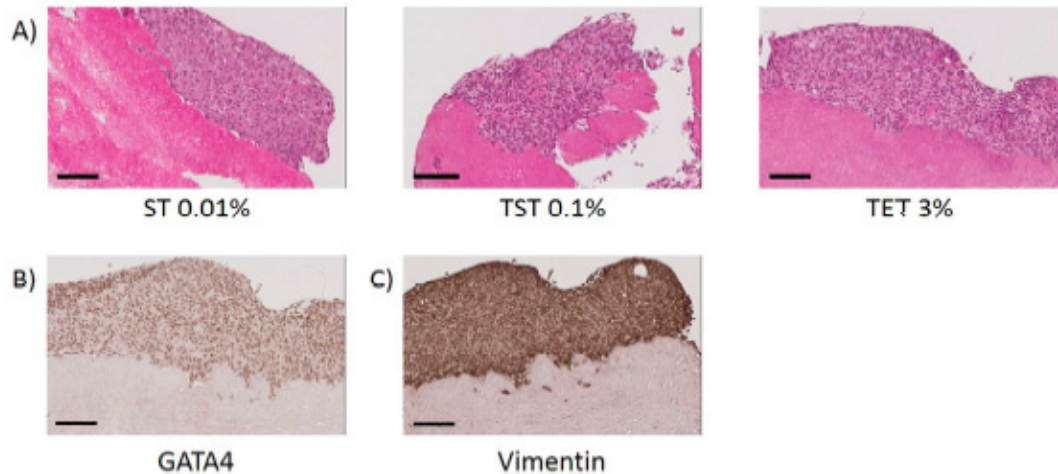
Figure 6. Attachment of SCs onto DTs. ( A ) H and E staining of tissues decellularized with ST 0.01%, TST 0.1% and TET 3% onto which SCs can reattach. Scale bar = 100 µm; ( B ) SCs express GATA4 onto DTs. Scale bar = 100 µm; ( C ) SCs express vimentin onto DTs. Scale bar = 100 µm.